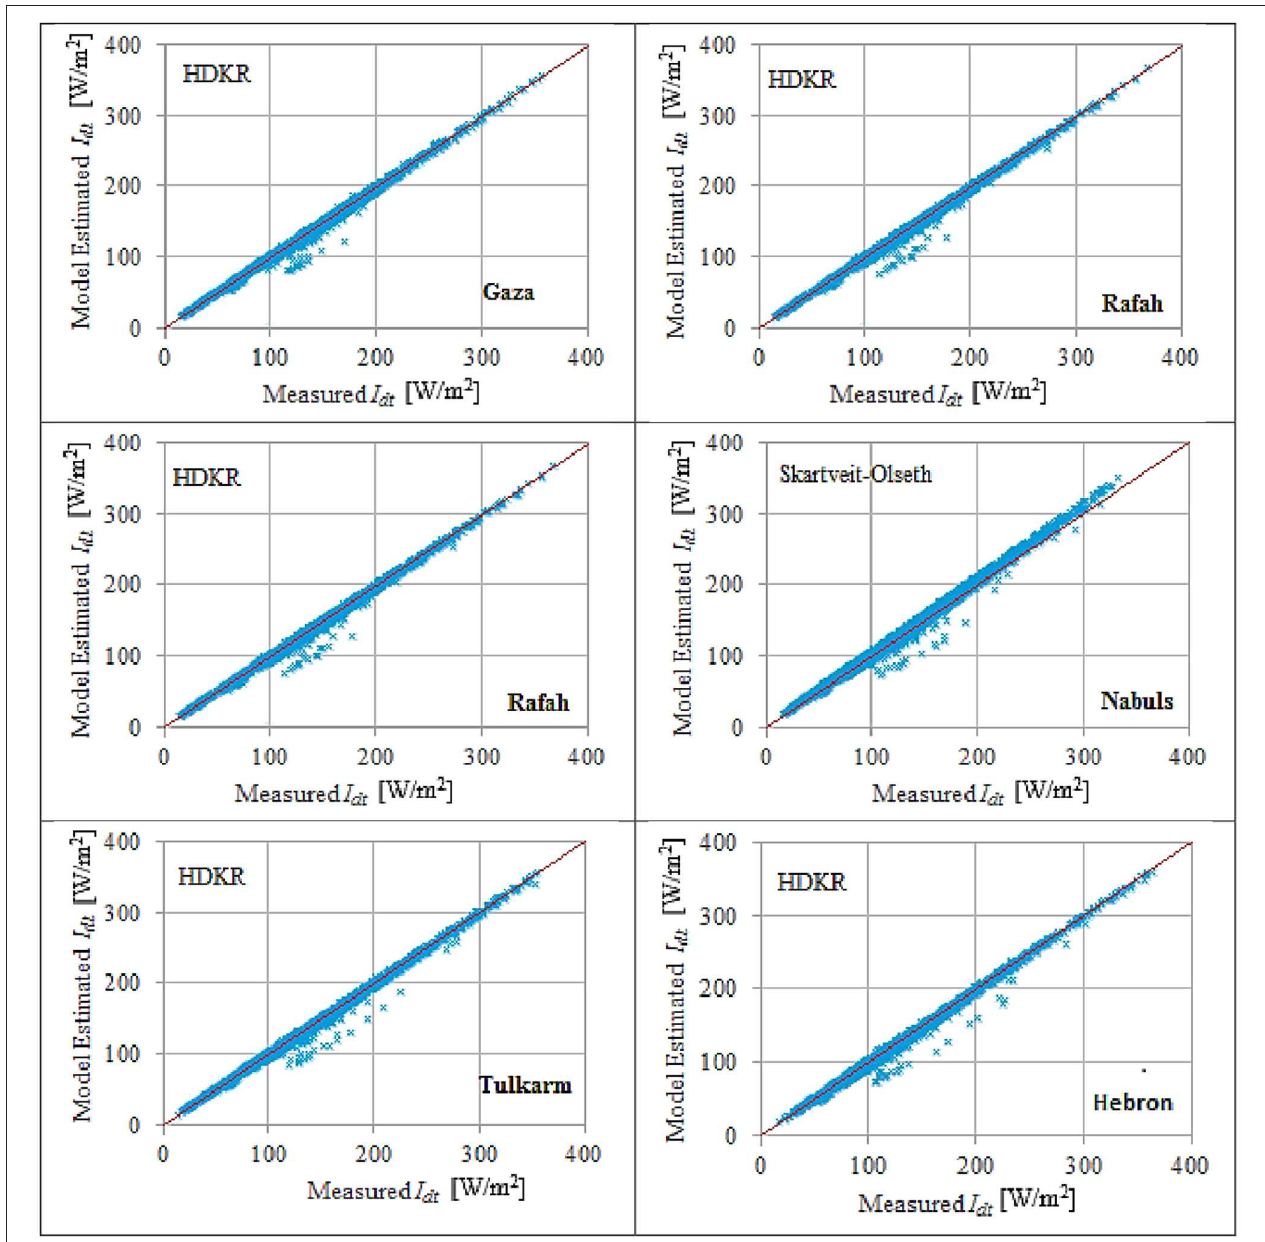
FIGURE 4 | The most accurate diffuse-sky solar irradiance transposition models for the considered cities (8,700 points depicted in the graph) (blue dot), y = x relation (red